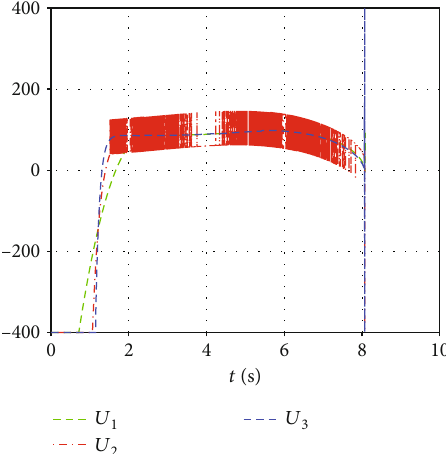
Figure 27: Acceleration instruction u